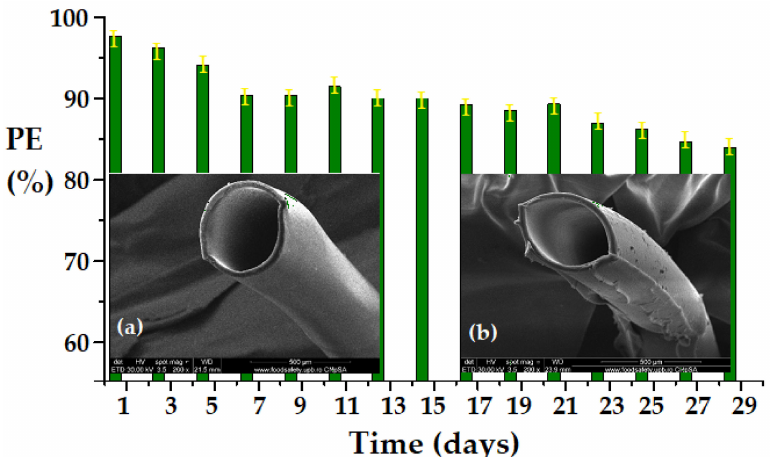
Figure 17. Pertraction efficiency (PE%) of Chi/sEPDM/PPy–CM during four weeks of operation in the system (30 ppm H 2 S, in nitrogen, with a feed flow of 4 L/min and a receiving phase with 10 − 2 mol/L cadmium ions at pH = 2): ( a ) SEM image of the membrane at the beginning of the experiment; ( b ) SEM image of the membrane at the end of the